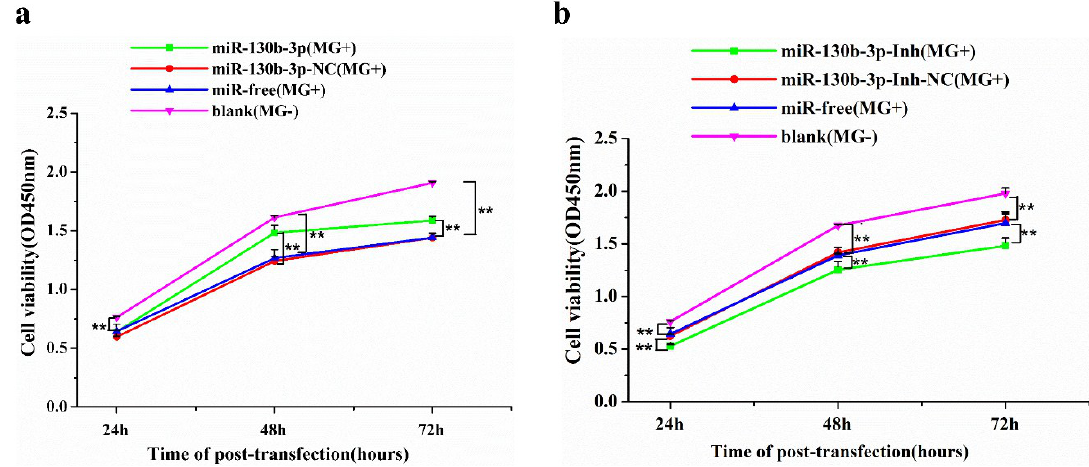
Figure 2. miR-130b-3p promoted cell proliferation of MG -infected DF-1 cells. ( a ) Overexpression of miR-130b-3p promoted proliferation of MG -infected DF-1 cells; ( b ) Inhibitors of miR-130b-3p restrained proliferation of MG -infected DF-1 cells. DF-1 cells cultured in 96-well culture dishes were incubated with 10 µ L MG (1 × 10 10 CCU/mL) for 2 h. Then, the infected cells were